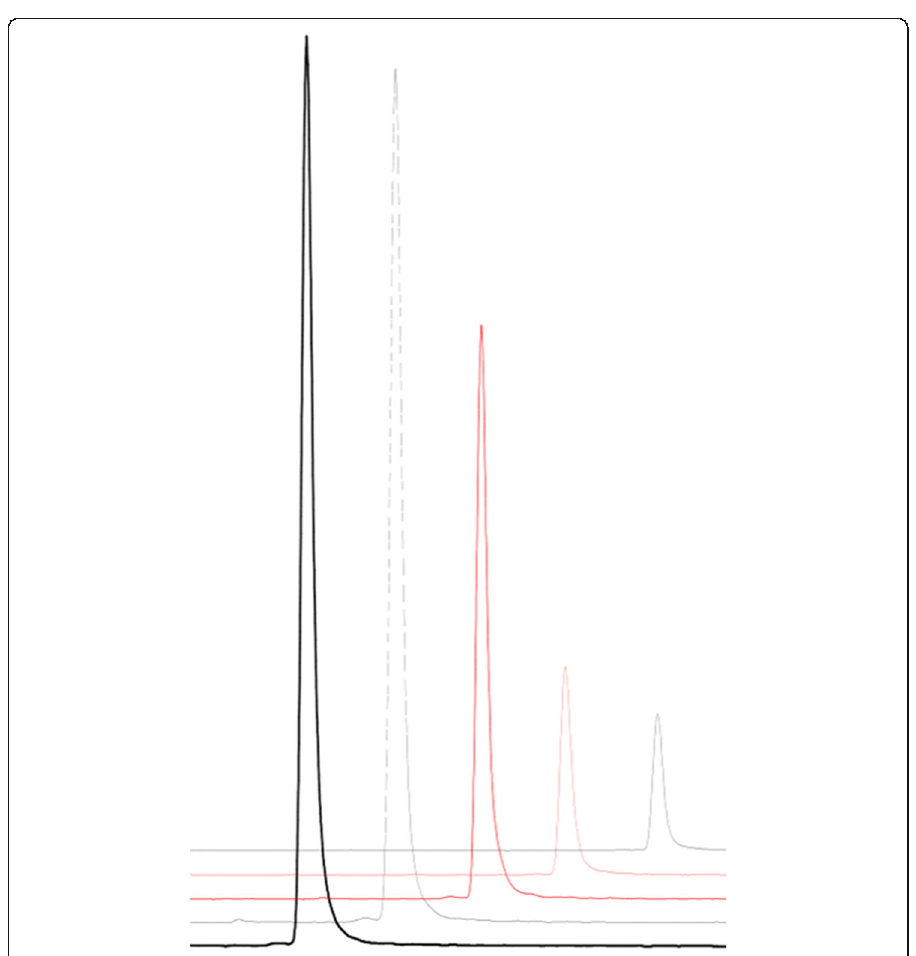
Fig. 5 Stability of [ 68 Ga]Ga-FAPI-46 (black solid: 0 min, black dash: 30 min, red solid: 1 h, red dash: 2 h, black dot: 3